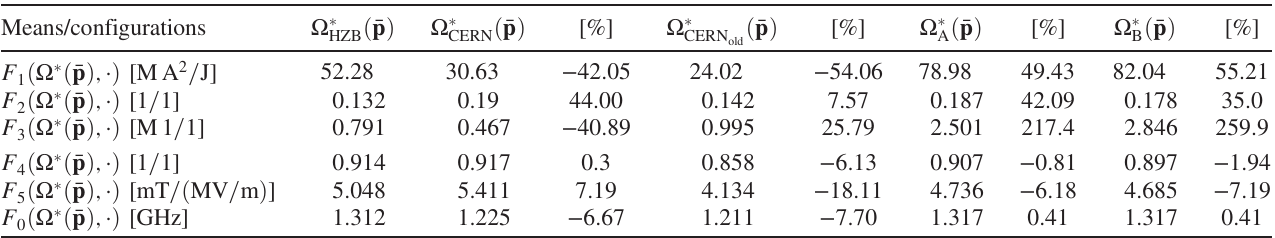
TABLE VII. Results of the MO optimization for the third mode — objective space a . Means/configurations